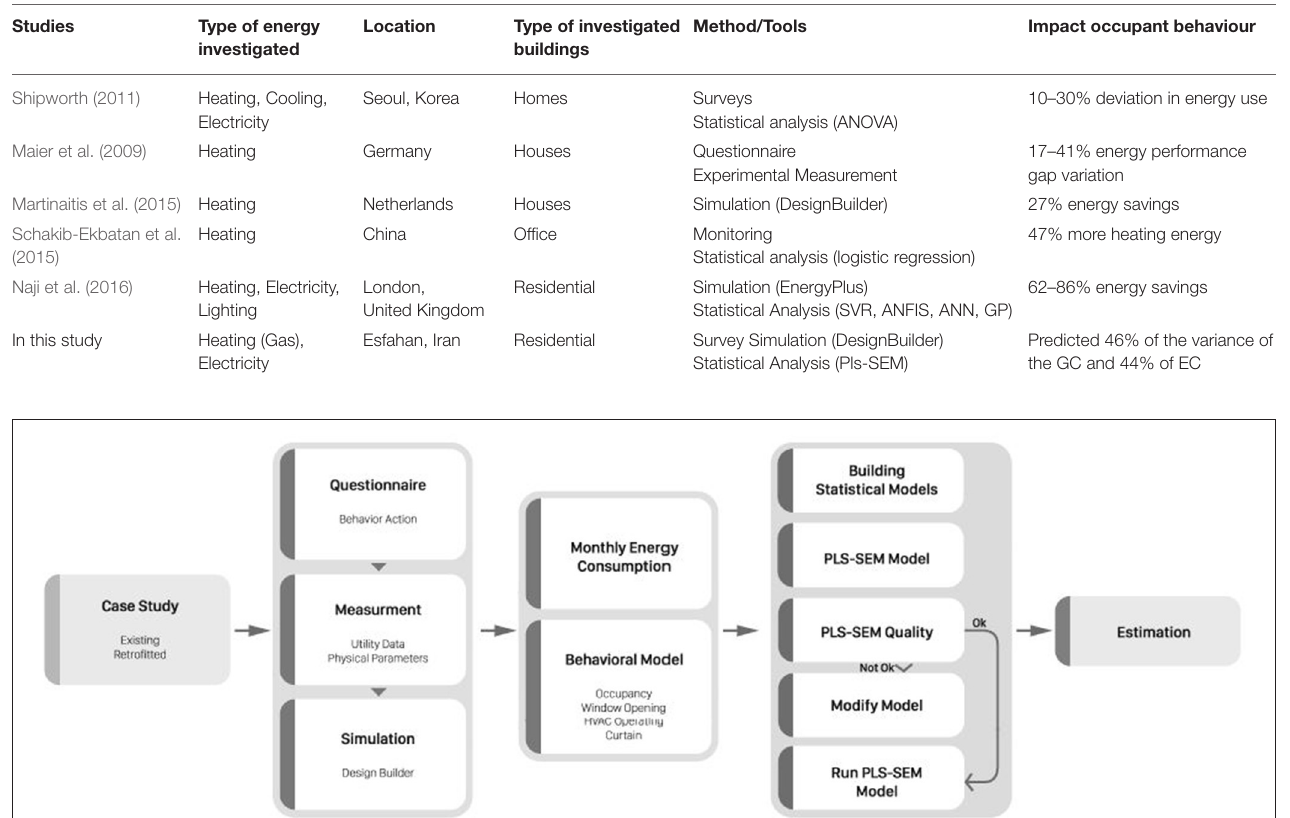
TABLE 1 | Review of papers investigating the impact of occupant behaviour on energy performance.